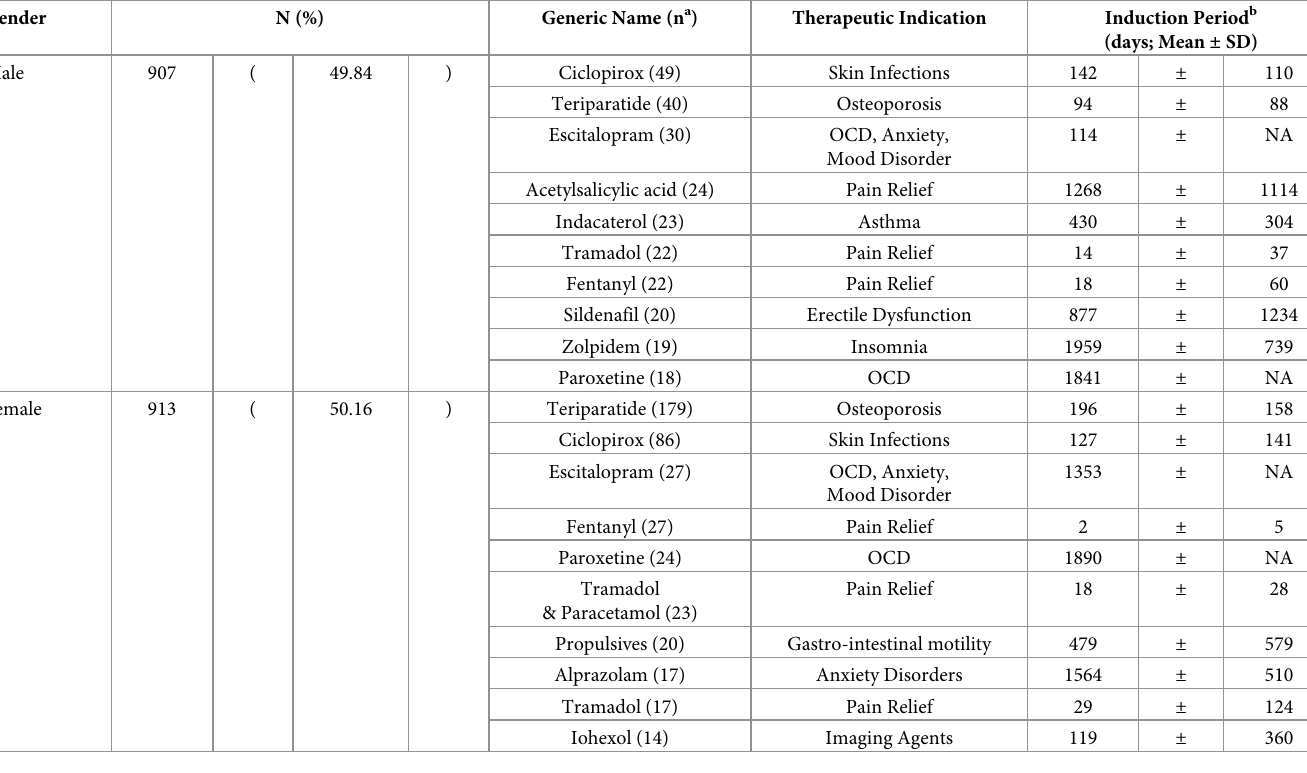
Table 4. Frequency of therapeutic ineffectiveness reports reported in the KAERS in 2016 and the 10 most frequently reported generic name according to